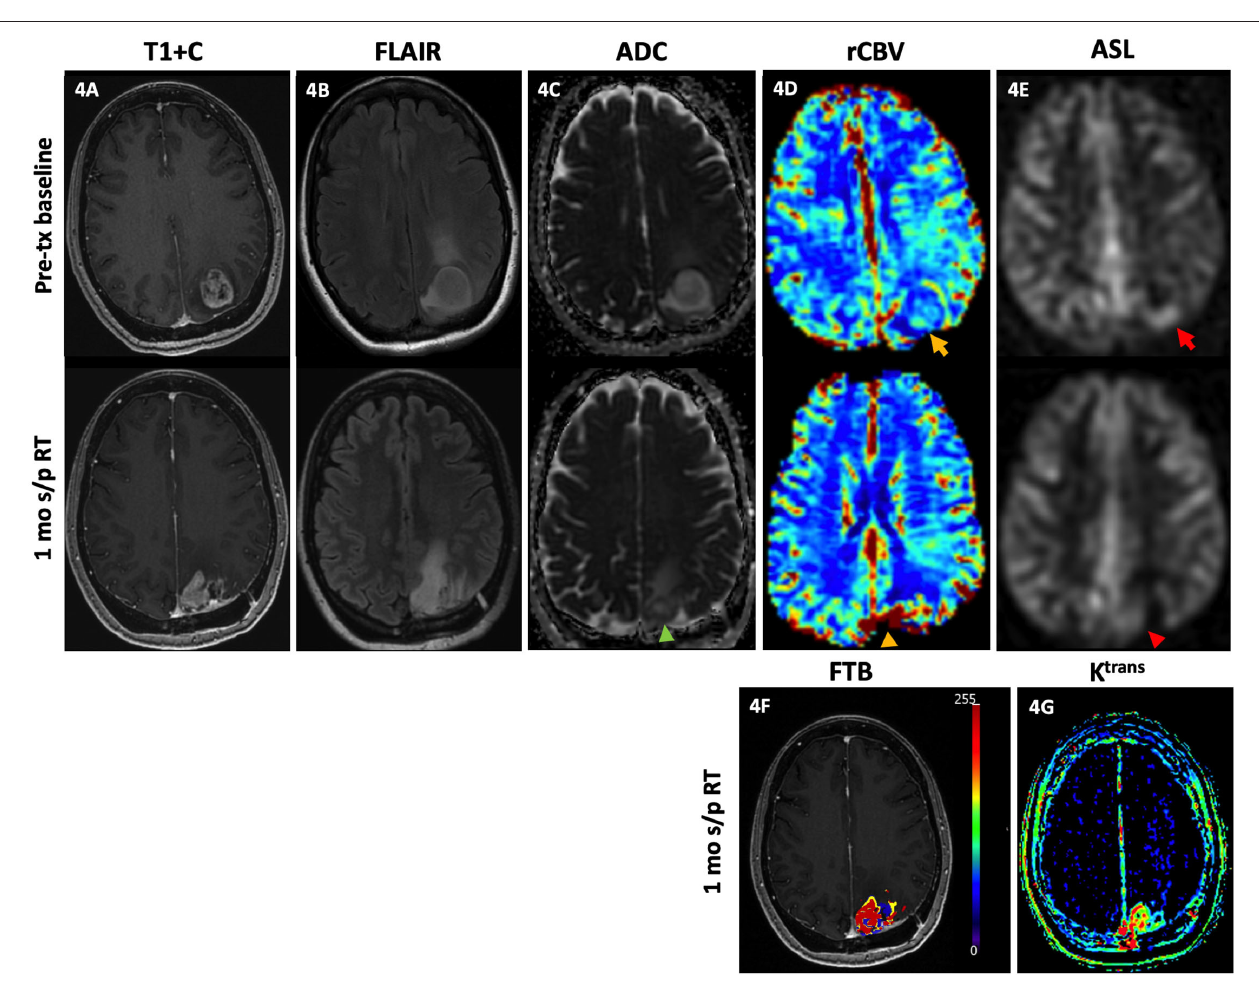
FIGURE 4 | Tumor recurrence. A 49-year-old female with GBM (IDH wt, MGMT + ) was initially diagnosed with an enhancing left parietal mass [ (A) , top row] with associated lesional and perilesional FLAIR hyperintensity [ (B) , top row], diffusion restriction [ (C) , top row], increased rCBV [ (D) , top row, yellow arrow], and ASL hyperperfusion [ (E) , top row, red arrow]. She then underwent gross total resection and concurrent CRT with minimal residual enhancement of the resection cavity margins without nodular enhancement, diffusion restriction, or increased rCBV or ASL signal (not shown). One month after completion of RT, there is new focal nodular enhancement at the medial aspect of the resection bed [ (A) , bottom row] with associated FLAIR hyperintensity [ (B) , bottom row], diffusion restriction [ (C) , bottom row, green arrowhead], increased rCBV [ (D) , bottom row, yellow arrowhead], and ASL hyperperfusion [ (E) , bottom row, red arrowhead]. There is increased FTB high, within the lesion as reflected by the red-colored areas (F) , and increased vascular permeability on the K trans map (G) . Note on the rCBV, FTB, and K trans maps, a color scale of blue to red represents the incremental increase in values from low to high. The findings of increased enhancement, FLAIR hyperintensity, diffusion restriction, rCBV, FTB high and K trans favor recurrence. Subsequent resection of the lesion showed recurrent GBM. ADC, apparent diffusion coefficient; ASL, arterial spin labeling; FLAIR, fluid-attenuated inversion recovery; FTB, fractional tumor burden; GBM, glioblastoma; IDH, isocitrate dehydrogenase; K trans , volume transfer coefficient; MGMT, O-6-methylguanine-DNA methyltransferase; mo, months; rCBV, relative cerebral blood volume; RT, radiation therapy; s/p, status post; T1 + C, post-contrast T1-weighted images; tx, treatment; wt, wildtype.